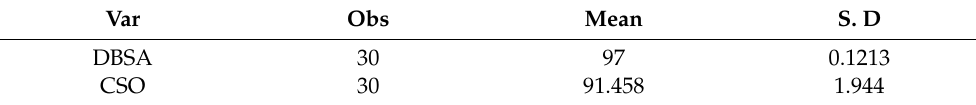
Table 17. Z-test descriptive statistics.